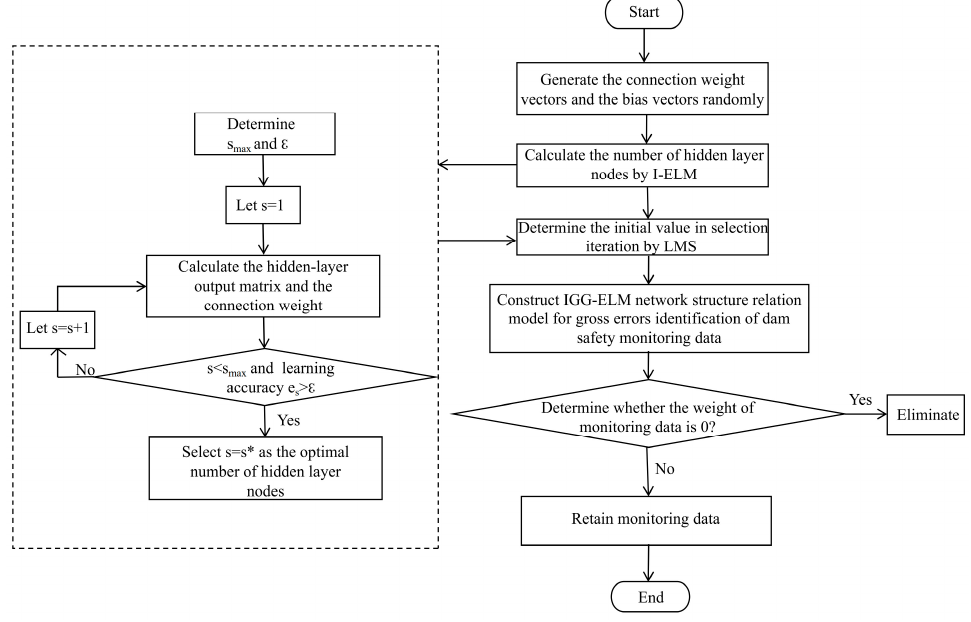
Figure 3. Flow chart of gross errors identification by LMS-IGG-ELM method.